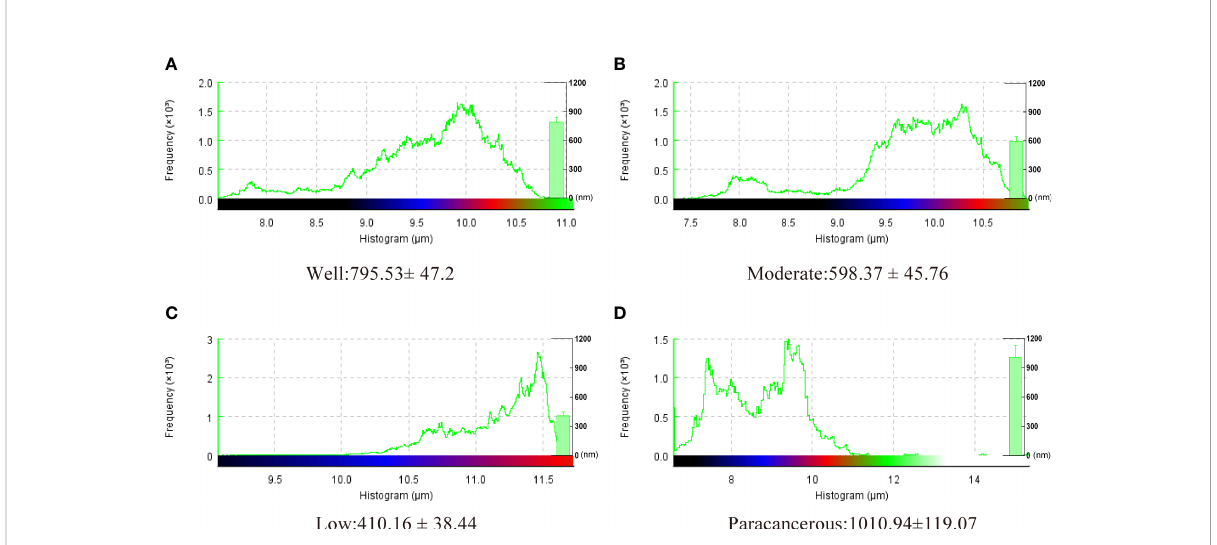
FIGURE 8 Average tissue stiffness tested by Bio-AFM. Well-differentiated OSCC had a higher Young ’ s modulus than moderately and poorly differentiated OSCC (kPa, P <